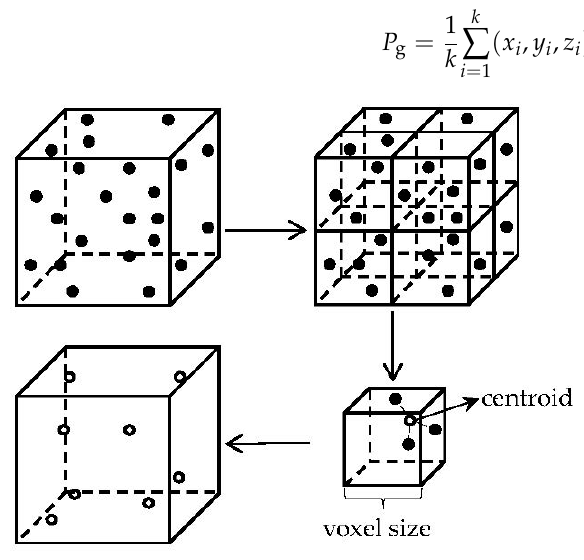
Figure 6. Process of voxel down-sampling.